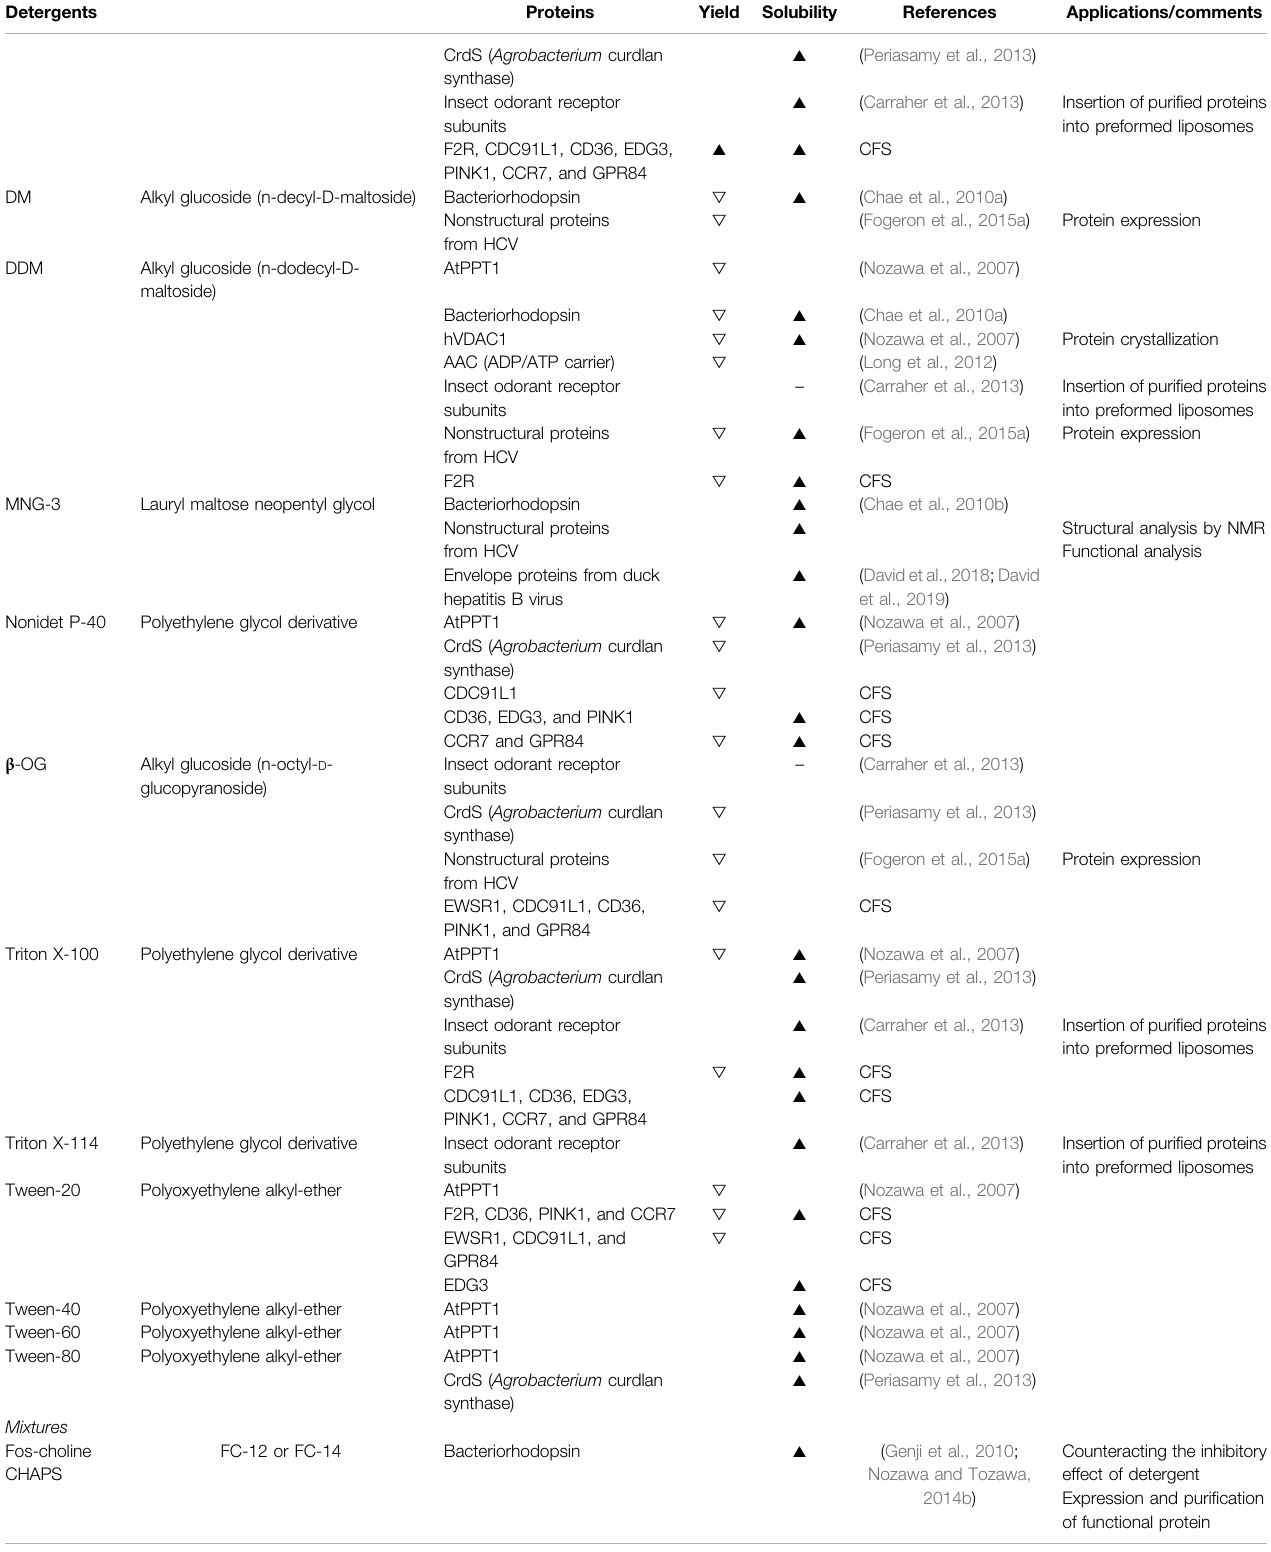
TABLE 4 | ( Continued ) Summary of detergents whose use has been described to produce membrane proteins with the